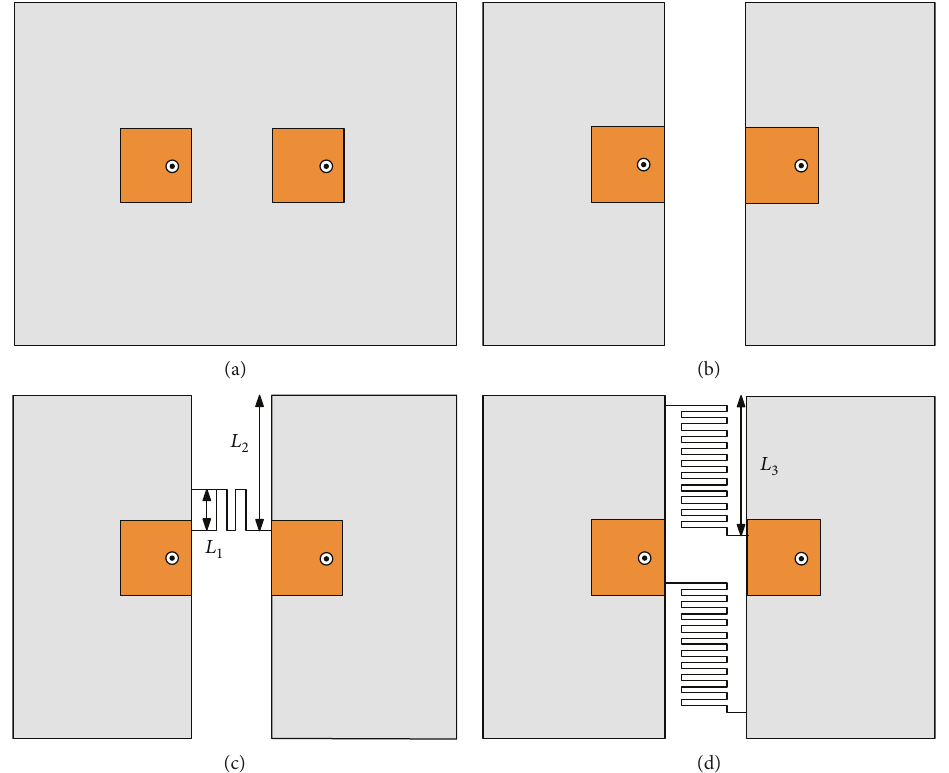
Figure 1: The design evolution of the dual-element microstrip antenna array equipped with MLs. (a) Prototype A. (b) Prototype B. (c) Prototype C. (d) Prototype